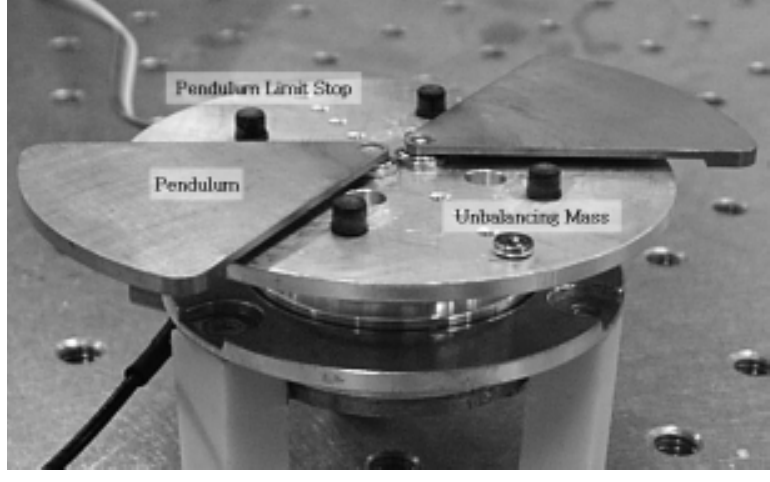
Fig. 12. Experimental setup.